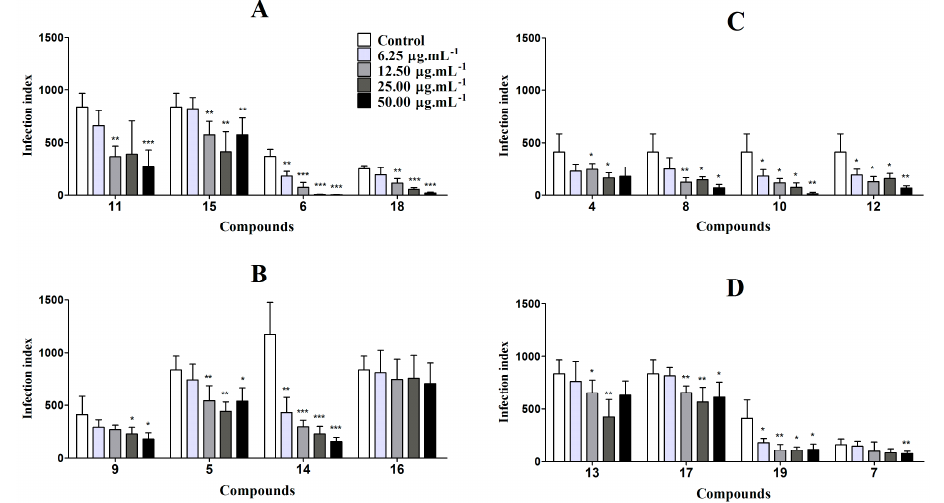
Figure 1. Effect of 1,4-diaryl-1,2,3-triazole derivatives ( 4 – 19 ) of the neolignans 1 – 3 on intracellular amastigotes. Peritoneal macrophages were infected with L. amazonensis and treated with different concentrations of the compounds. Infection index was calculated 24 h after treatment. Bars represent the mean ± SD of six replicates. * p ≤ 0.05, ** p ≤ 0.01, *** p ≤ 0.001 for the different concentrations versus untreated cells (control) (Student’s t- test). ( A ) trimethoxy series; ( B ) dimethoxy series; ( C ) methoxy series; ( D ) methylenedioxy series (substitution pattern of ring A).